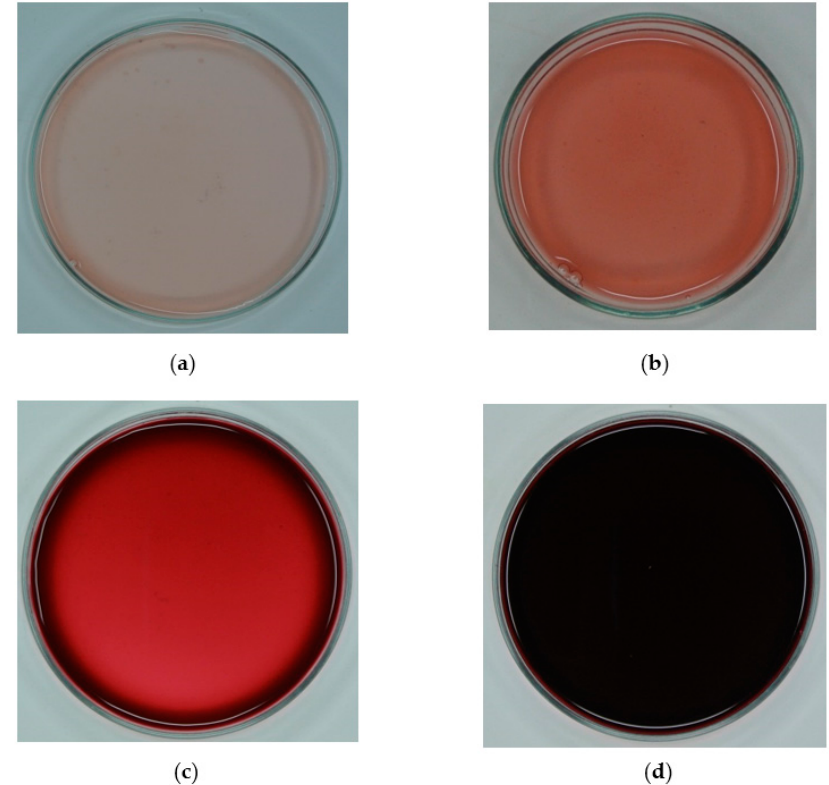
Figure 3. Effect on visual color of fresh murta juice and fresh arrayan juice under centrifugal block freeze crystallization (CBFC): ( a ) fresh murta juice, ( b ) cryoconcentrated murta juice, ( c ) fresh arrayan juice, and ( d ) cryoconcentrated arrayan juice.